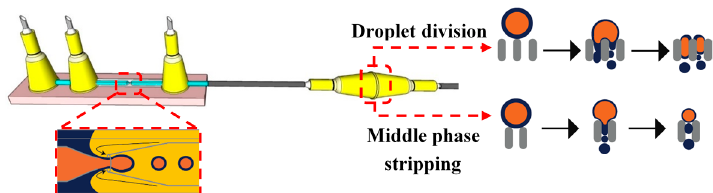
Figure 30. A membrane-integrated glass capillary device for the formation of small double emulsion droplets. The membrane is placed between the two Luer–Stub adapters [178].